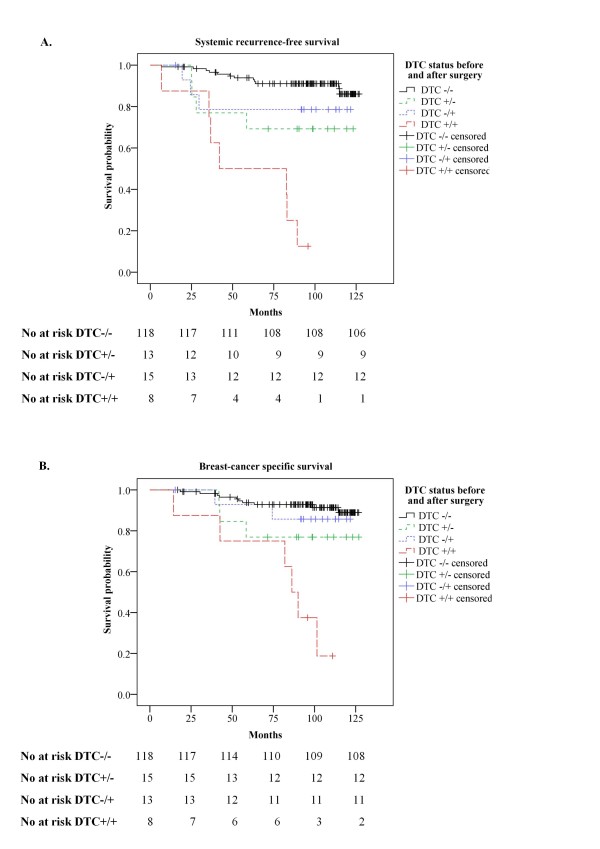
Kaplan Meier estimates according to the presence of disseminated tumor cells in bone marrow before and after surgery. Kaplan-Meier estimates of systemic recurrence-free survival (A), and breast-cancer specific survival (B) according to the presence of disseminated tumor cells (DTCs) in bone marrow (BM) only before surgery (DTC +/−, n = 13), only after surgery (DTC −/+, n = 15), both before and after surgery (DTC +/+, n = 8) and no presence of DTCs in BM (DTC −/−, n = 118). P-values were calculated by the log-rank test. The numbers of patients at risk are indicated below each plot.